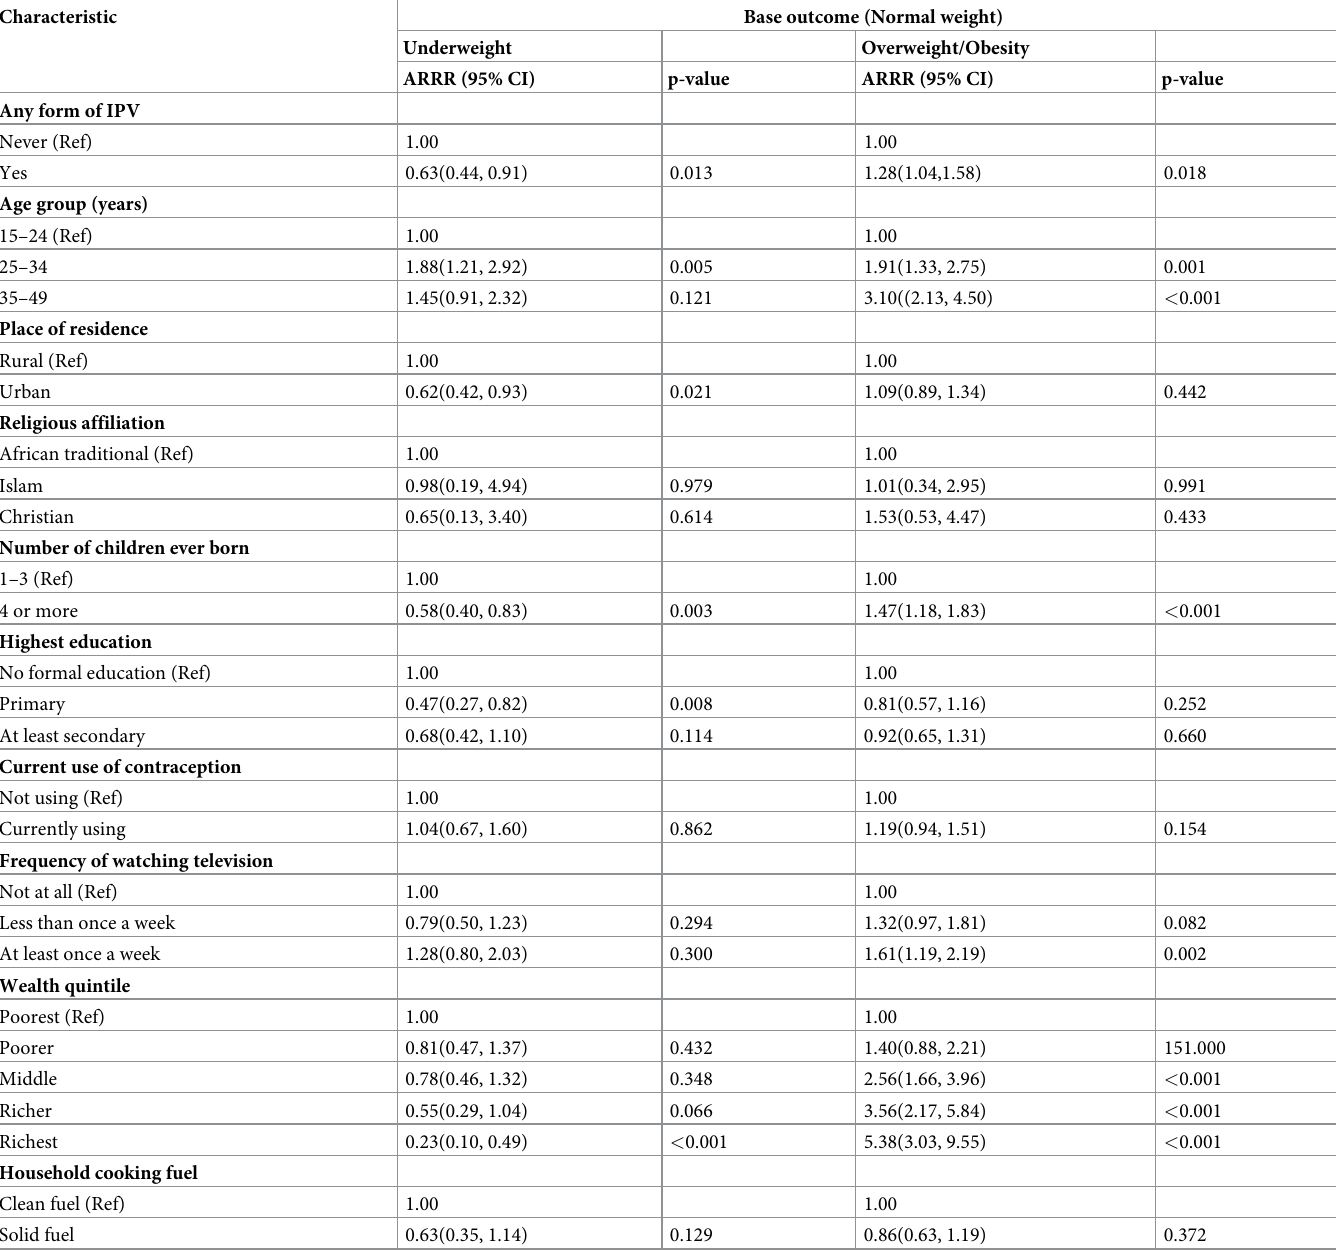
Table 2. Association between exposure to intimate partner violence and women’s nutritional status (weighted N = 4,391).